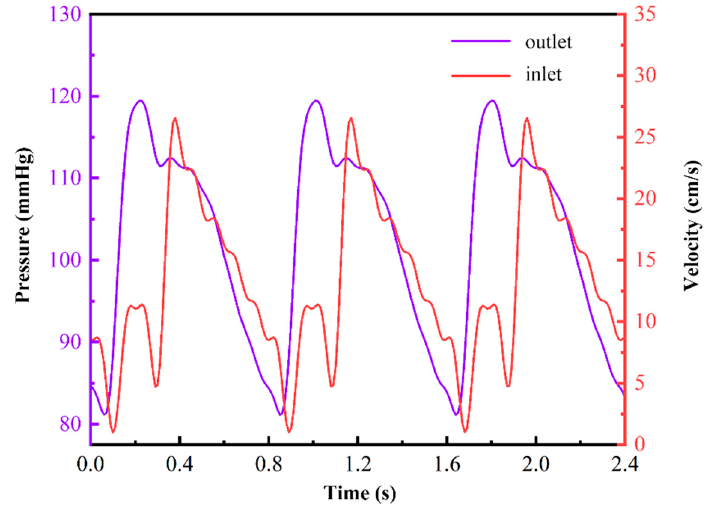
Figure 4. Boundary conditions: velocity profile prescribed at the inlet (LM) and pressure profile imposed at the outlets (LCX, DB, and LAD).